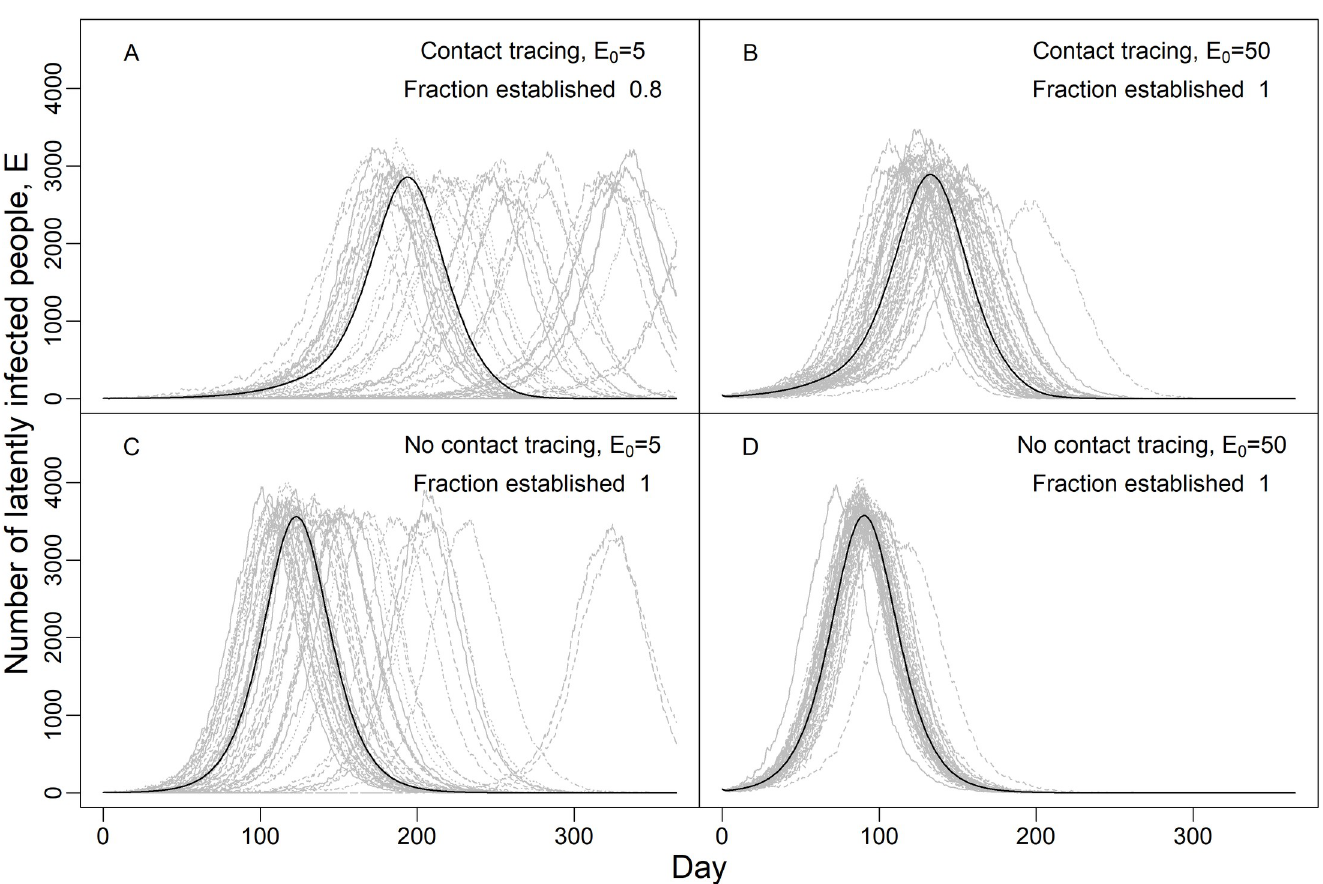
Fig 4. Variability in the timing and outcome of epidemics due to stochastic variation in individual transmission. Lines show number of latently infected individuals in the E class over time for 1 year with moderate social distancing that reduces contact rates by 40% ( κ = 0.6). Grey lines show runs from a single stochastic simulation and the black line shows the deterministic outcome. The fraction of epidemics that establish is the fraction of simulations where the maximum number of people infected at any time exceeds the starting number infected. The four scenarios shown include different starting numbers of latently infected individuals on day 0, E 0 (A, C: 5; B, D: 50), and with (A, B) or without (C, D) contact tracing (CT) which lowered R 0 from 1.57 to 1.33. The delay from symptom onset to testing and tracing 1/ τ Is was 10d. The modeled population of 100,000 people had 15 tracers making 12 calls/day, and each case had an average of 10 contacts which is intermediate between pre-lockdown and lockdown conditions; this scenario is the same as the yellow line in Fig 1.